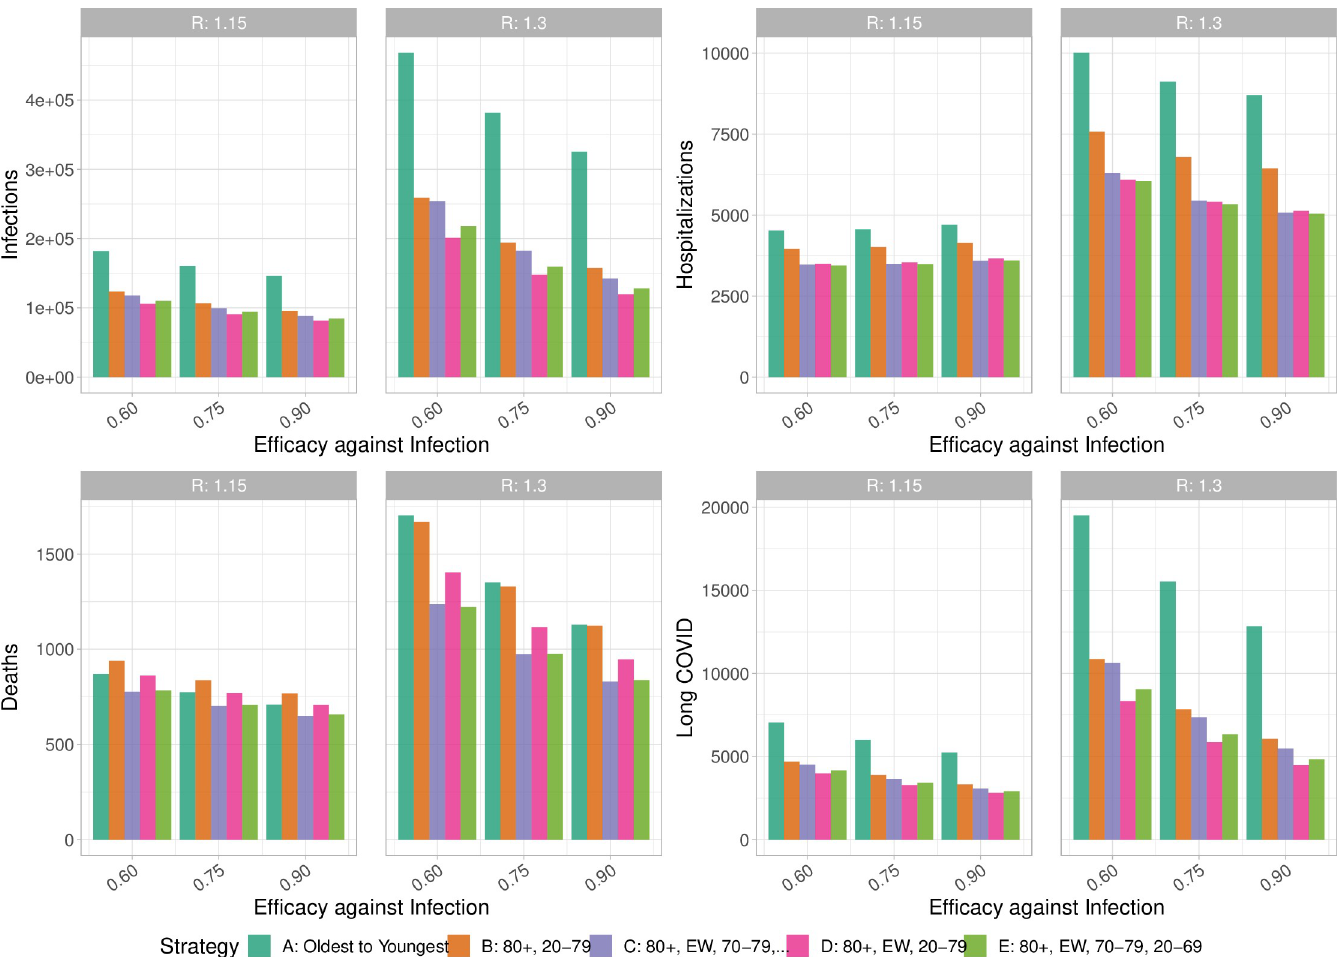
vaccinating over all age groups (strategy B), with the exception that this gives less reduction in